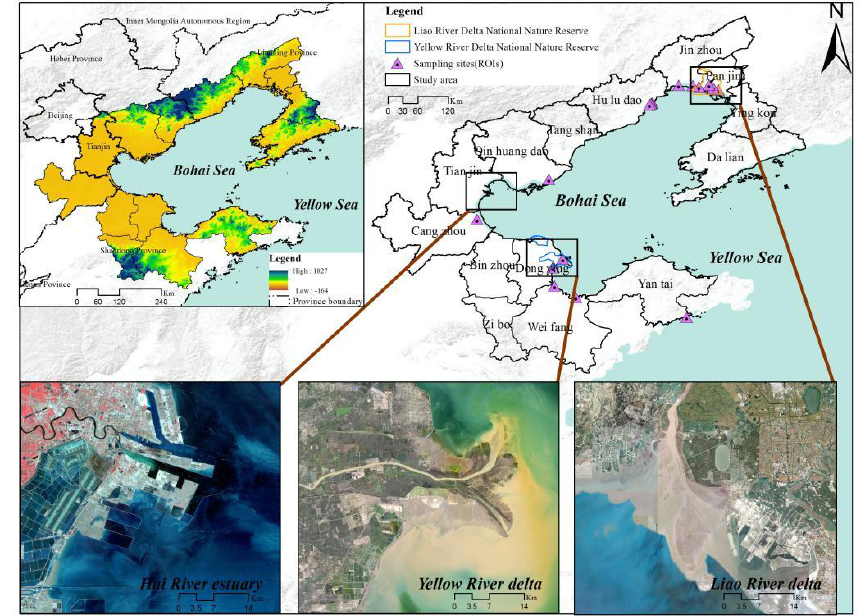
Figure 1. Location of the study area.